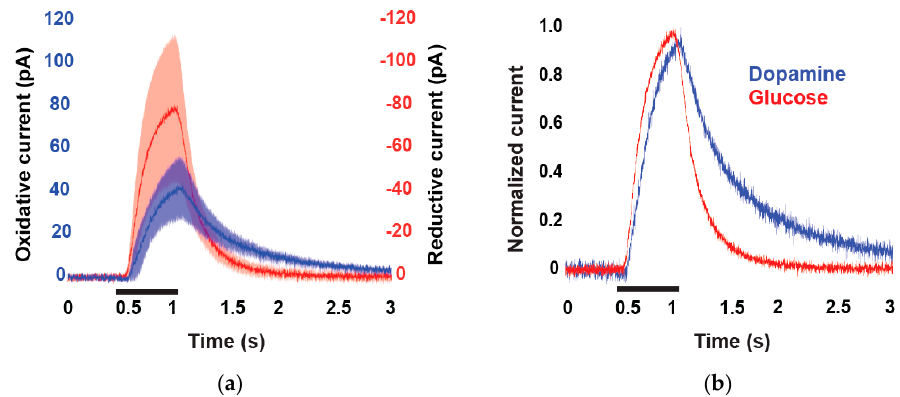
Figure 4. ( a ) The temporal response for detection of puffing a solution containing 20 µ M dopamine (blue) and 25 mM glucose (red) against the biosensor surface when applying a potential of +0.5 V and − 0.5 V vs. an Ag/AgCl reference electrode, respectively. ( b ) Normalized detection response of the dopamine ‐ and glucose ‐ containing solution. The black band indicates the timing for the 500 ms injection pulse applied to the glass microinjection pipette.